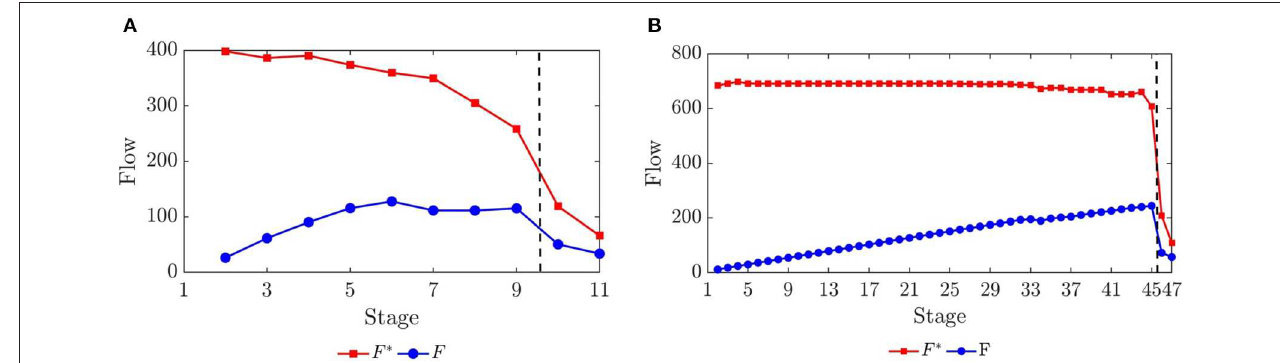
FIGURE 8 | (Color online) Failure is characterized by the transmission of flow near or at global force capacity. Evolution of the transmitted tensile force flow F and the maximum flow F ∗ for (A) DI and (B) DII. Some bonds remain in the path of the macrocrack at the final